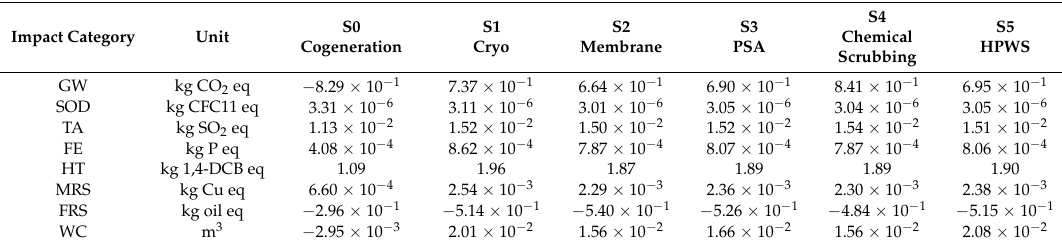
Table 4. ReCiPe Midpoint (H) characterized total impacts calculated through the avoided burden approach for the different conversion routes of biogas, with reference to a functional unit of 1 m 3 of used biogas.